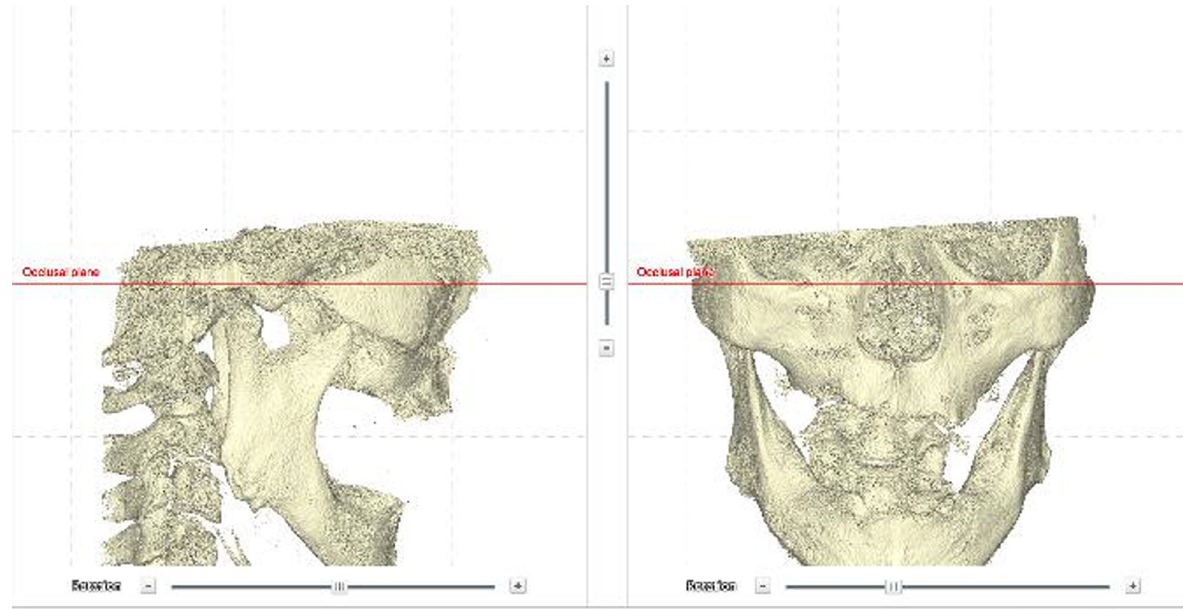
Fig. 1 The Frankfort plane was first drawn in the software (Nobel Clinician)